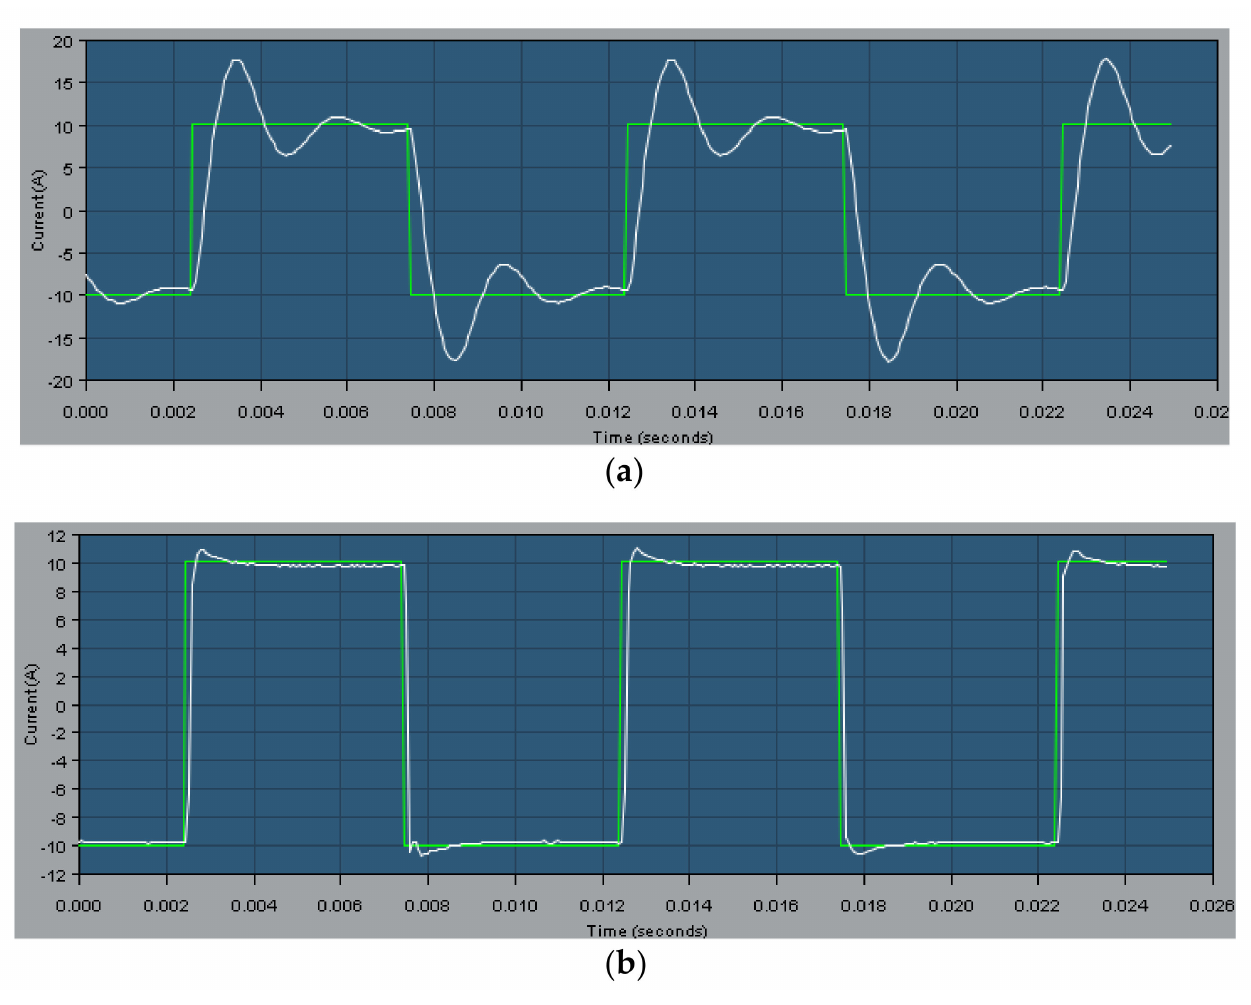
Figure 17. ( a ) Current change curve before debugging; ( b ) Current change curve after debugging. As shown in Figure 17, the error between the actual current and the rated current is basically eliminated after adjustment, which meets the control requirements of the manipulator. The data from the starting point A to the ending point B obtained in the above simulation are applied to the actual motion control of the manipulator. Experimental process of manipulator trajectory planning is shown in Figure 18. By saving the data of the end-effector of the manipulator during the movement and using the data analysis software, the curve of the points passed can be drawn, as shown in Figure